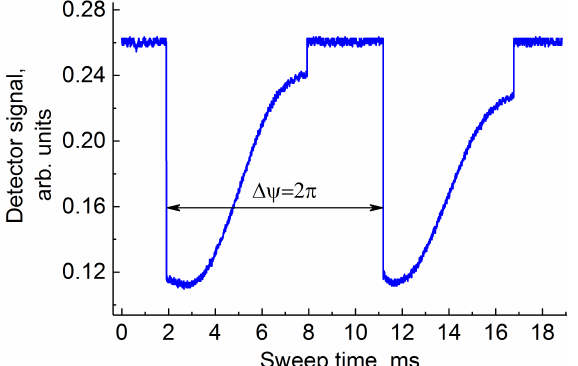
Figure 4. Measured dependence of the laser power on the change of the optical path from the laser to the resonator for a broader optical phase tuning range. The period of the curve corresponds to the optical phase change ∆ φ = 2 π . The locking is conserved for ∆ φ (cid:39) 3 π